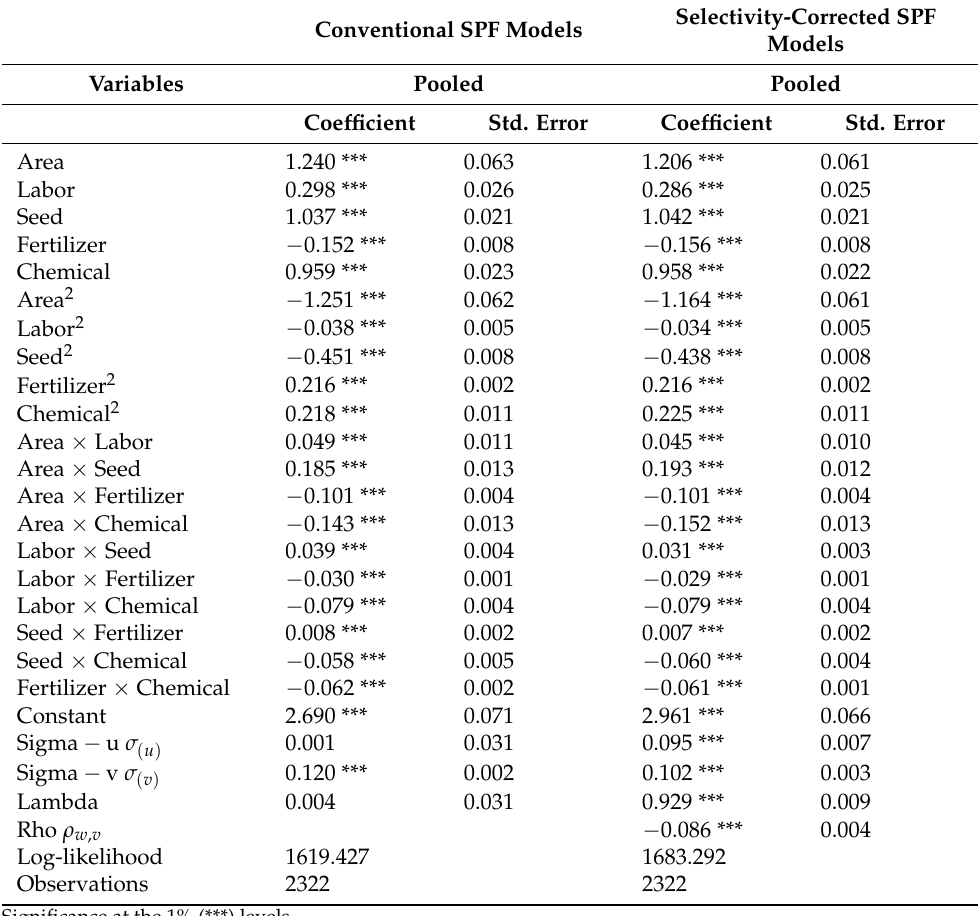
Table A2. Maximum likelihood estimate models for the